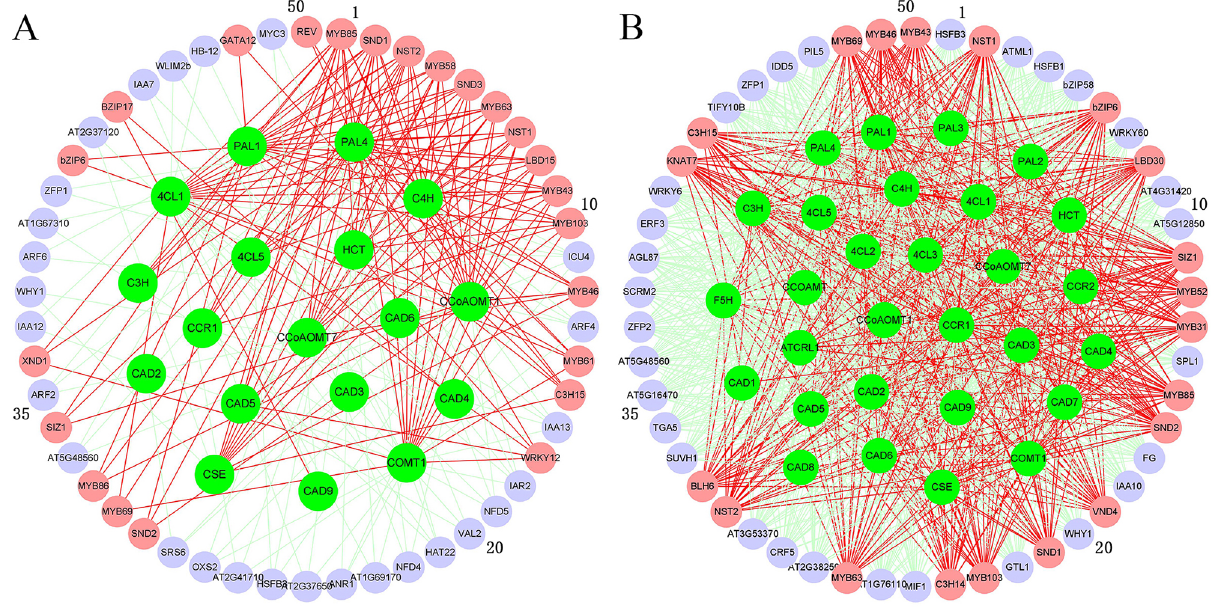
Figure 2. Regulatory network generated by triple-gene mutual interaction (TGMI) ( A ) and sparse partial least squares (SPLS) ( B ) for Arabidopsis thaliana lignin biosynthesis pathway using the microarray data generated from hypocotyledonous stem tissues. The green nodes represent pathway genes. All other nodes are the top 50 transcription factors that have the highest connectivity to pathway genes regardless of their colors. The light coral nodes represent positive known TFs of lignin biosynthesis pathway while the red edges are to show the connections of a true positive known pathway regulator with pathway